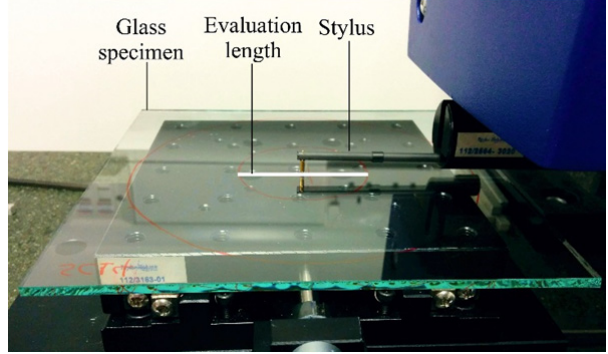
Fig. 1 Surface roughness